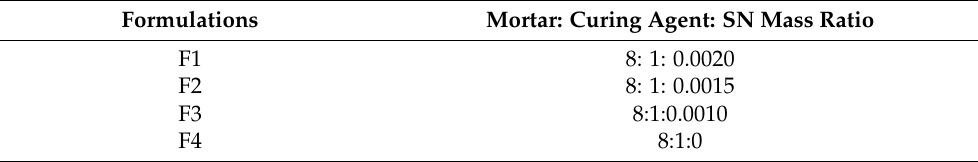
Table 3. Formulations of silica nanoparticle (SN)-modified underwater composite-repairing